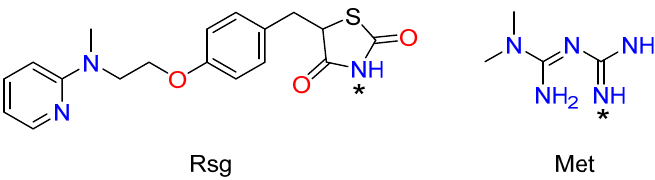
Figure 1. Chemical structures of the Rsg and Met with basic and acidic sites highlighted (*), respectively.